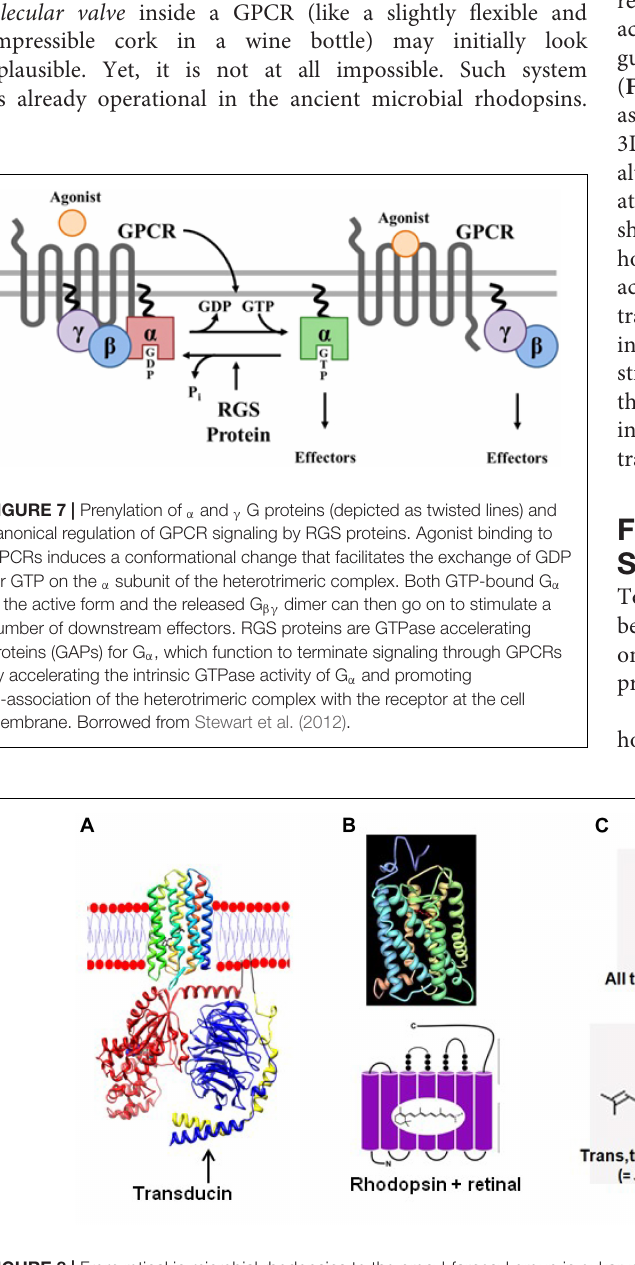
FIGURE 8 | From retinal in microbial rhodopsins to the prenyl-farnesyl group in eukaryotic GPCRs. (A) Schematic representation of microbial sensory rhodopsin II embedded in the membrane with transducin under it (both figure and legend borrowed from Wikipedia, 2018f). Rhodopsin is colored in a rainbow with the N-terminus red and the C-terminus blue. Bound retinal on the inside is in black for ease of visualization. For the transducin, the Gt-alpha subunit is red, beta is blue and gamma is yellow. Pseudo anchoring sites in black. The Gt-alpha subunit has a bound GDP that is colored by atom. The protein structures were created using UCSF chimera and then placed together in adobe illustrator. This illustration is the author’s own using the publicly available pdb data. Released into the public domain by the author (Dryan at English Wikipedia). (B) Crystal structure of Bovine Rhodopsin A (from Palczewski et al., 2000). Crystal structure of rhodopsin: a G protein-coupled receptor (GPCR). Note: originally uploaded (in 2006) to en:Wikipedia by Roland Deschain. Under: linear representation of the rhodopsin-retinal complex. (C) Upon absorption of a photon ( = photo-activation), the 11- cis -retinal chromophore isomerizes to the all- trans state. Farnesol, which is synthesized in all eukaryotes, occurs in several isoforms. For most of them, the function is largely unknown. We hypothesize that upon binding of a ligand to its GPCR receptor, isomerization of the prenyl group may occur, resulting in a switch toward the receptor’s active conformation. However, this is hypothetical because experimental data for this possibility are currently